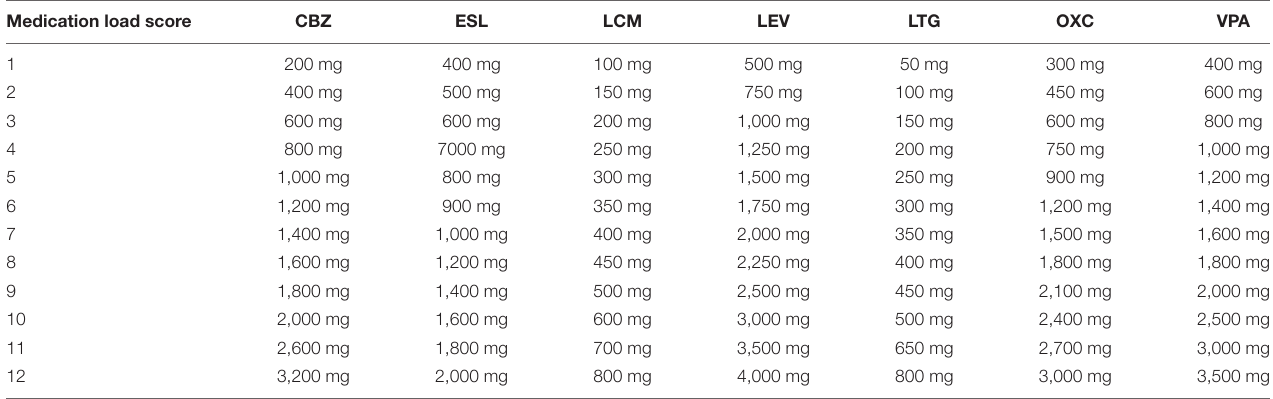
TABLE 1 | ASM drug load score system.